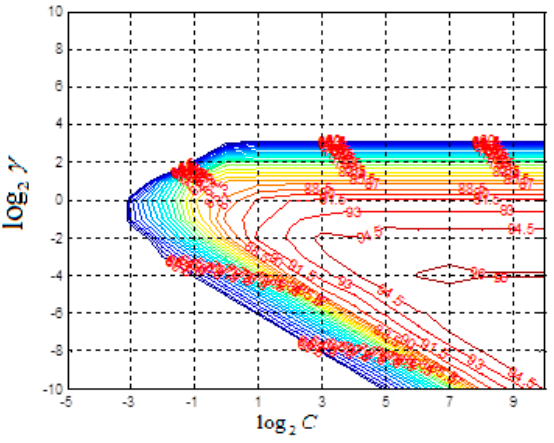
Figure 12. Contour map of grid optimization.